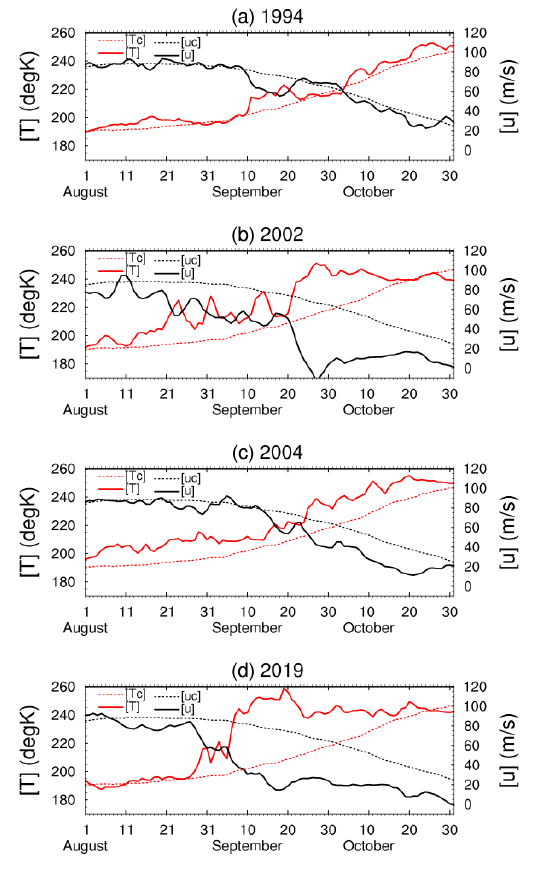
Figure 6. Time series of 10 hPa zonal-mean zonal wind (black) at 60 ◦ S and zonal-mean temperature (red) over the South Pole from July to September in ( a ) 1994, ( b ) 2002, ( c ) 2004, and ( d ) 2019. Dashed lines show the climatological-mean